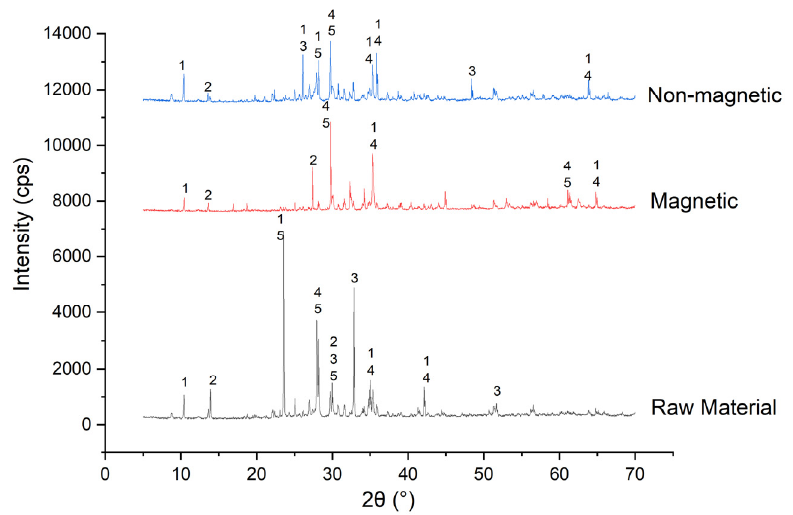
Figure 3. X-ray diffractogram of the silicate-based ore (raw material), magnetic and non-magnetic, and the main phases detected. 1: Dickite-Al 2 Si 2 O 5 (OH) 4 ; 2: Ferrohornblende-